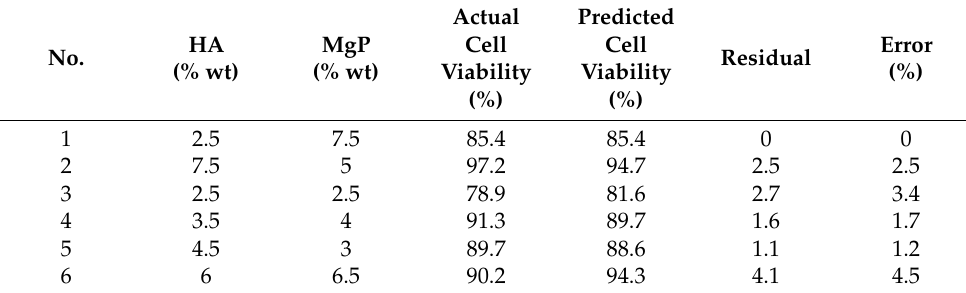
Table 7. The confirmation tests for cell viability.